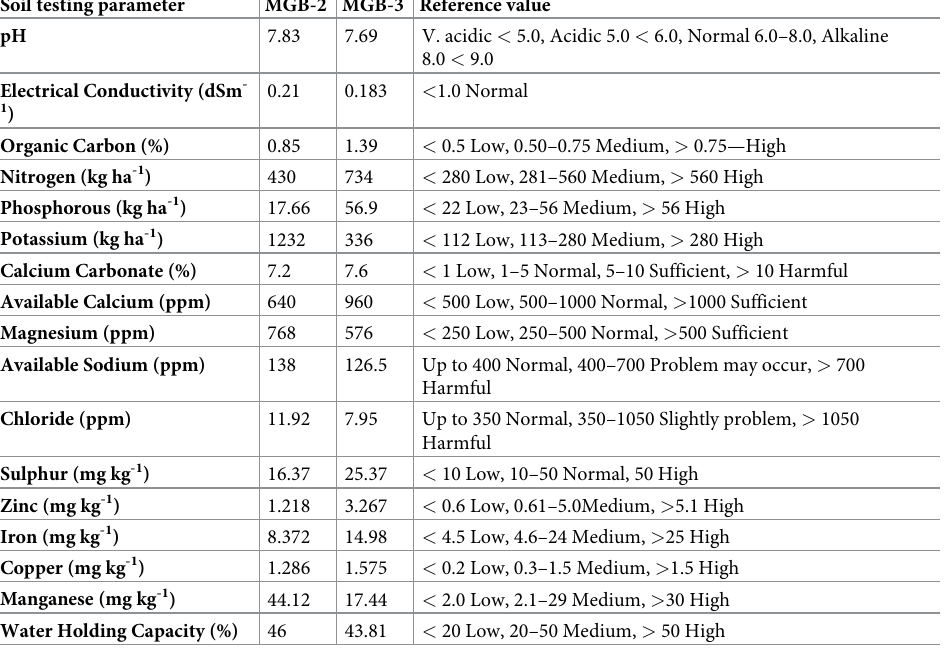
Table 1. Physio chemical parameters of the contaminated soil sample MGB-2 and MGB-3 from polluted near Bhi- lai steel